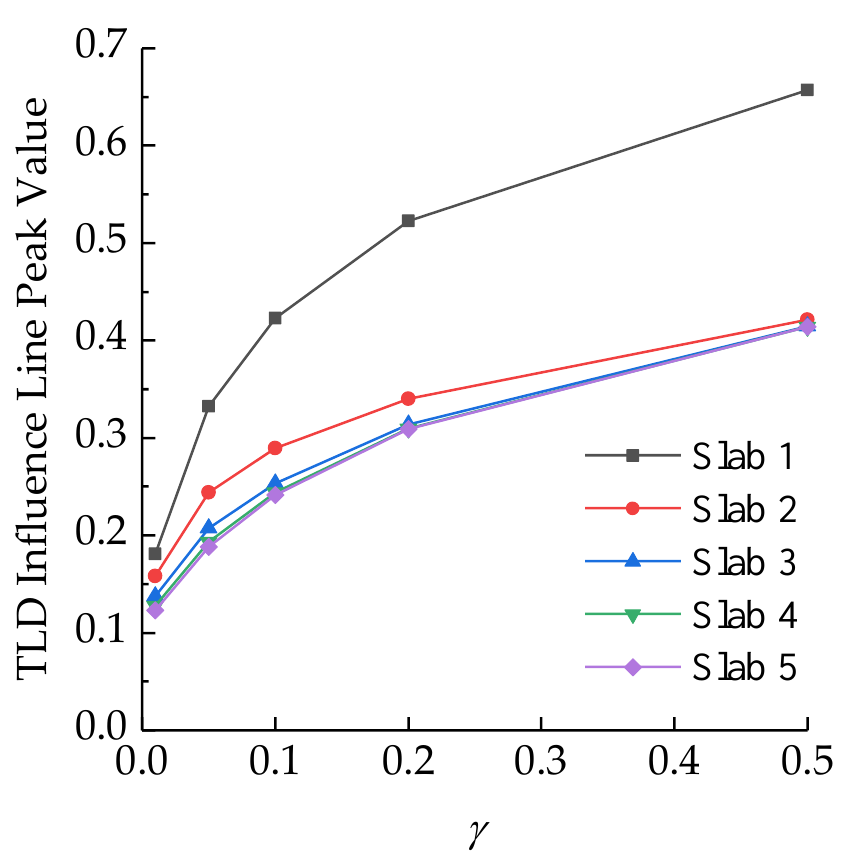
Figure 16. The peak values of influence lines of TLD for each slab at different relative stiffness.